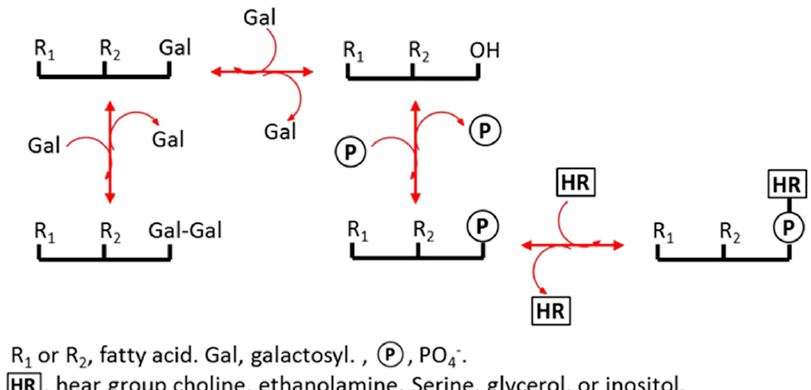
Figure 1. Schematic of glycerolipid turnover.